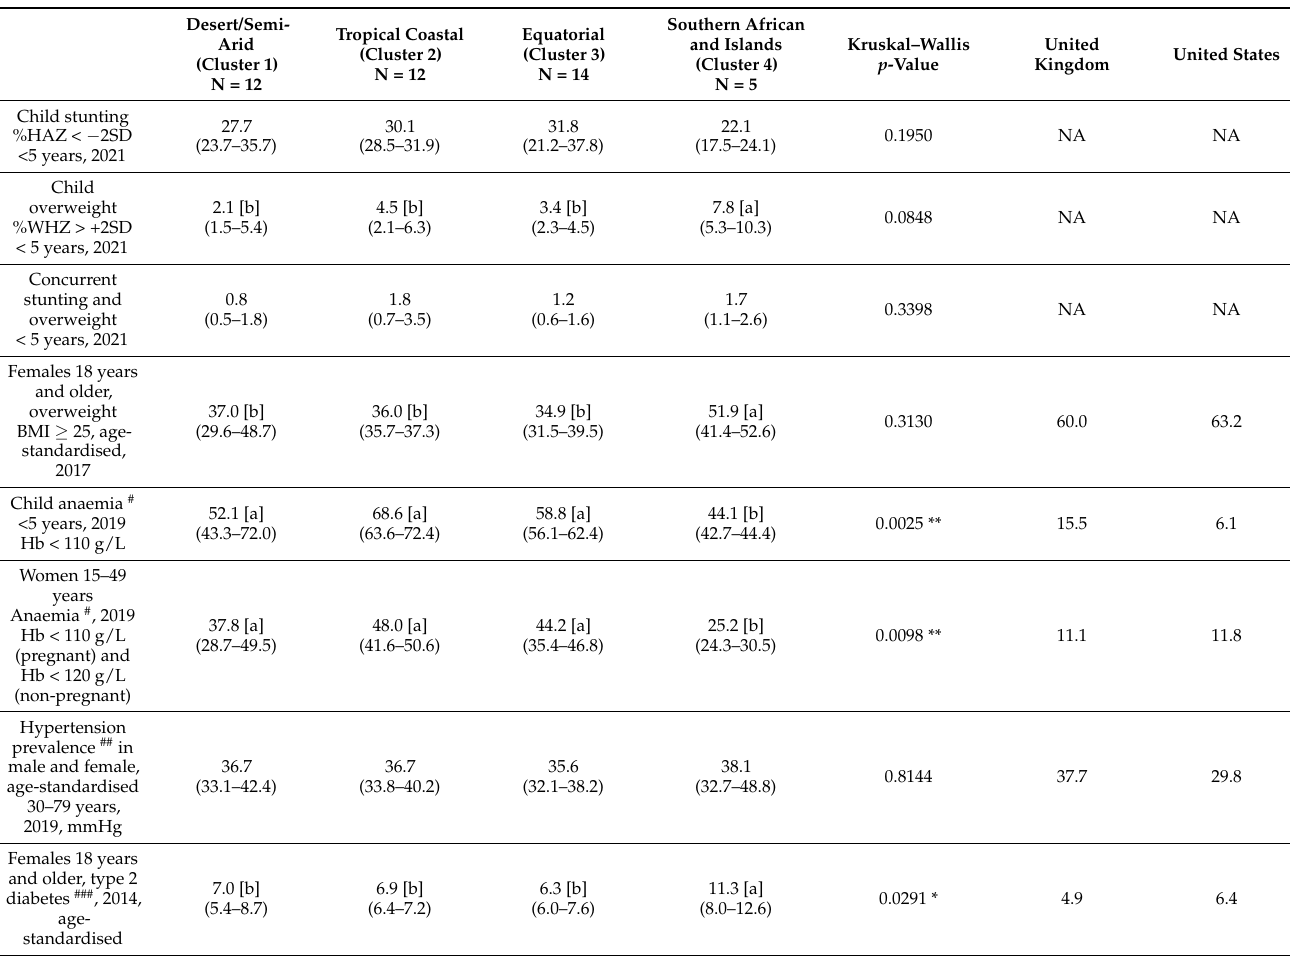
Table 5. Median and interquartile range values of anthropometric and health data of Clusters 1–4.